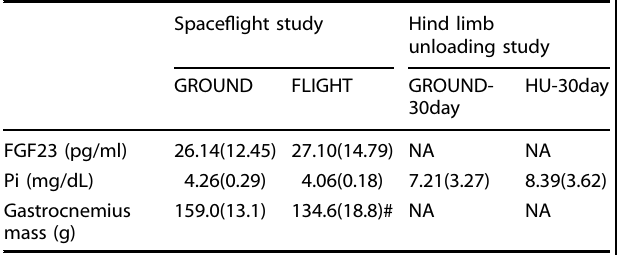
Fig. 1 α Klotho concentration is reduced after space fl ight. FLIGHT mice exhibited lower α Klotho vs GROUND. P value from unpaired t test provided above bars. Bars: Mean(SD). Table 1. Descriptive information from both the space fl ight study to the International Space Station, and the ground-based hind limb unloading (HU) study.